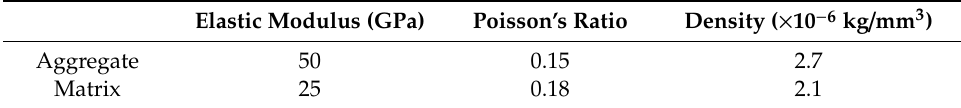
Table 4. Elastic parameters of meso-level constituents within concrete specimen.